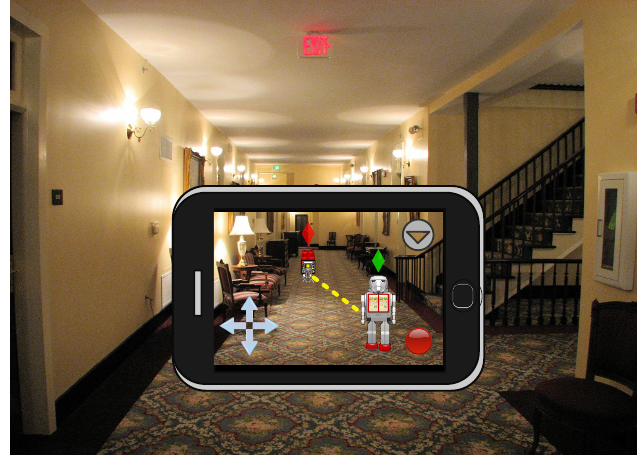
Fig. 1. Robot Devastation gameplay mockup from smartphone. The robots seen on the screen represent the players’ own